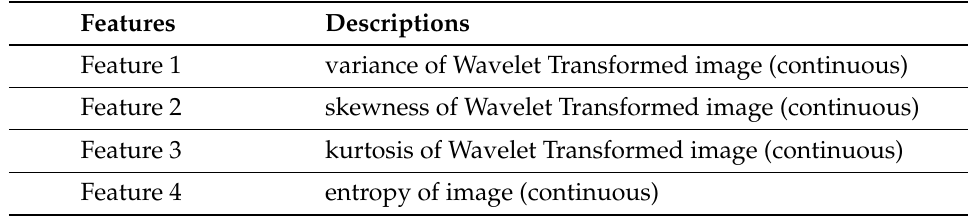
Table A2. Feature description for the banknote authentication